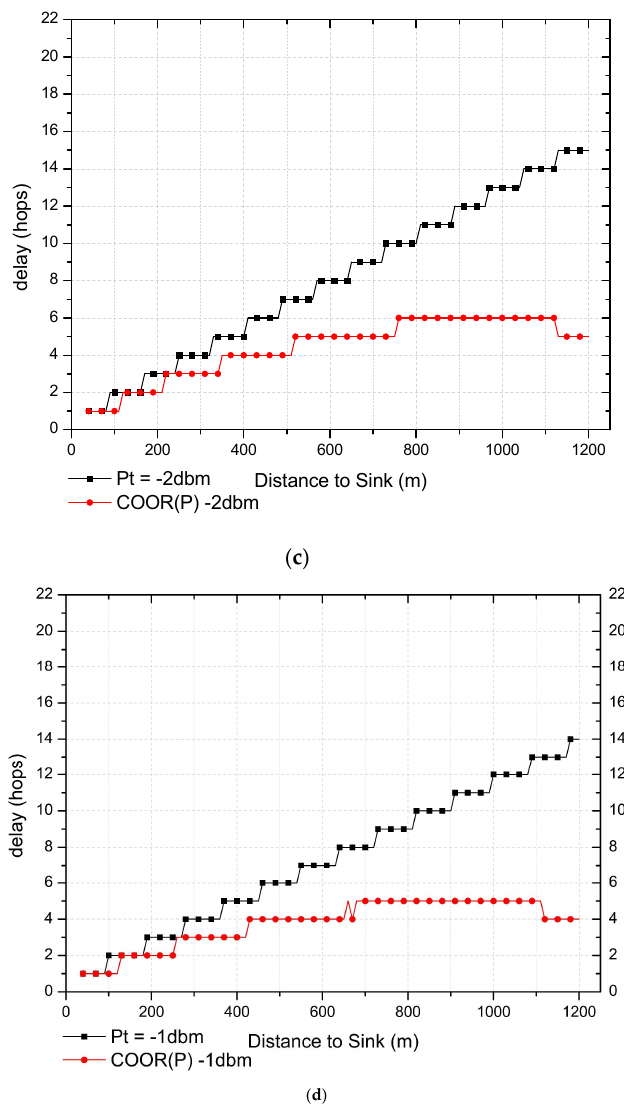
Figure 19. ( a ) Delay of node at different distance under r = 60, N = 2; ( b ) Delay of node at different distance under r = 70, N = 3; ( c ) Delay of node at different distance under r = 80, N = 4; ( d ) Delay of node at different distance under r = 90, N = 4.